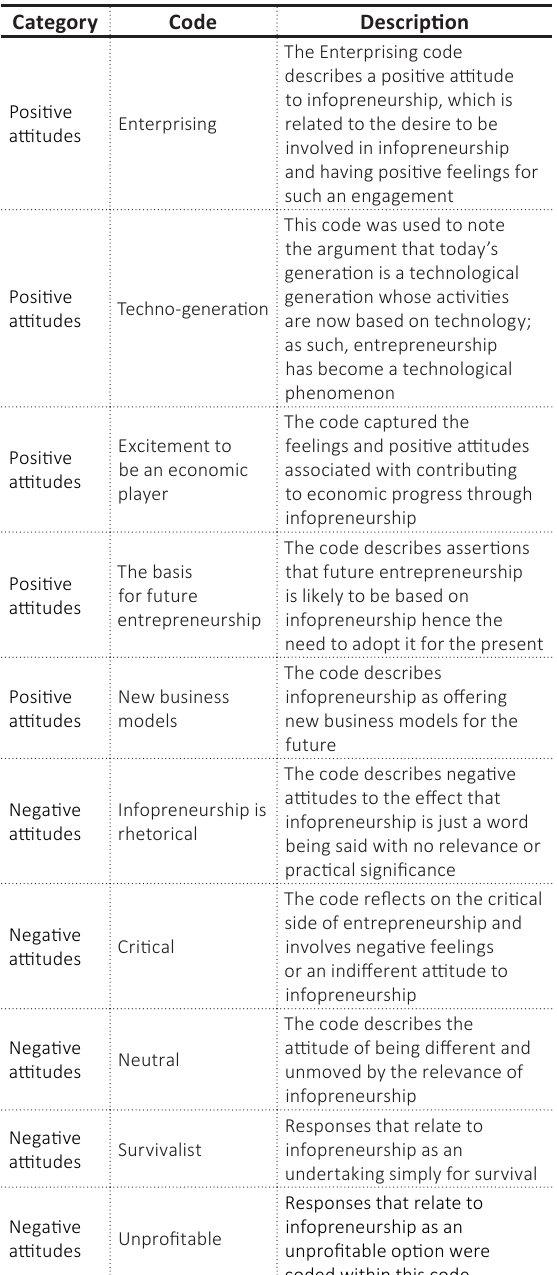
Table 2. Focus group discussion record